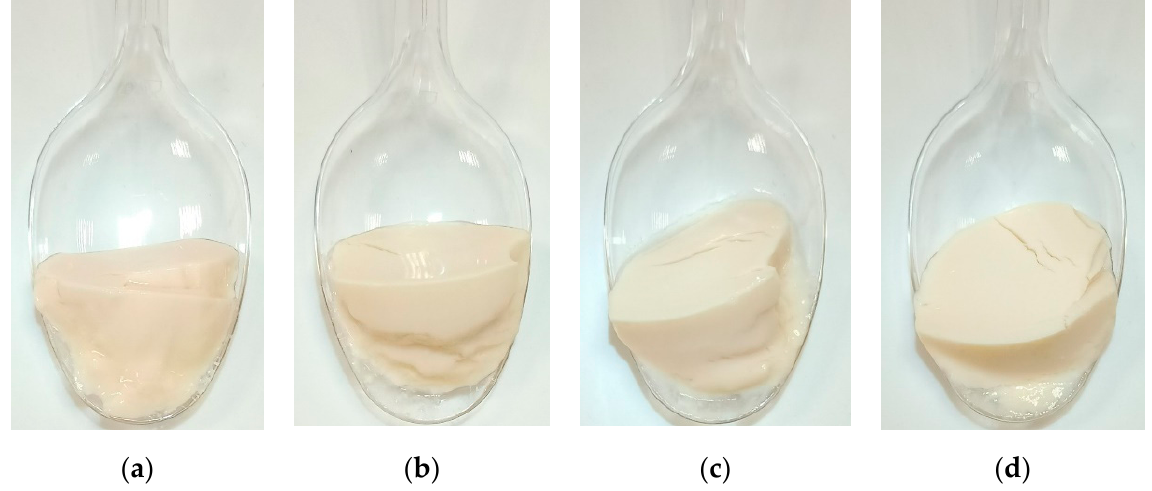
Figure 2. Appearance of the fermented YA, photographed after 12 h storage at 6 °C, removed from the fermentation container. ( a ) Yoflex control, ( b ) LcTR116, ( c ) LpMP070, ( d ) Lbp6.1. Table 3. Fermentation characteristics and color of yogurt alternatives produced with different strains.